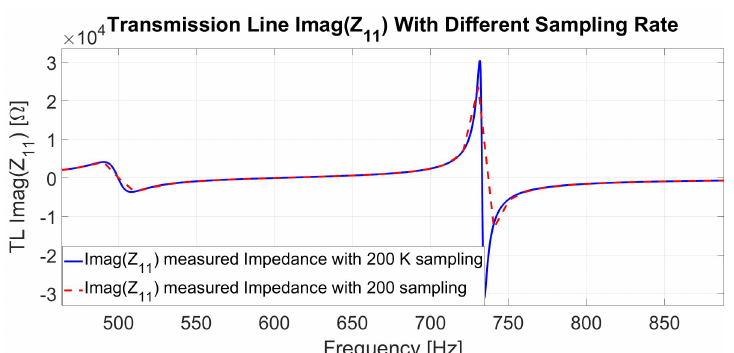
Figure 29. Frequency response measurement of the transmission line imaginary impedance ( Z 11 ) with different sampling